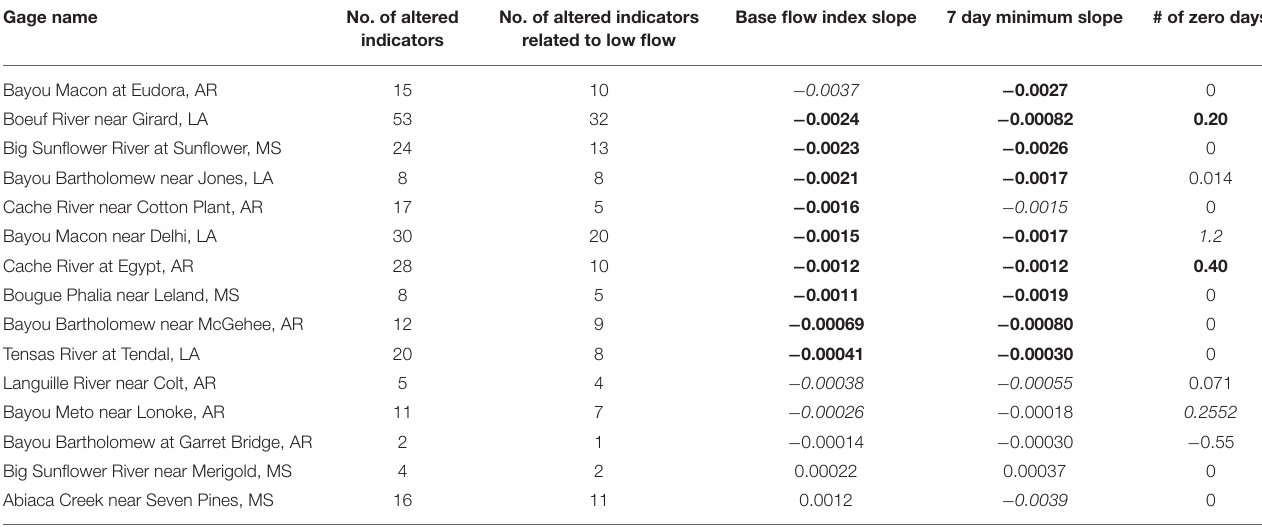
TABLE 2 | Statistics related to the Indicators of Hydrologic Alteration analysis for each gage; gages are listed from most altered to least altered with respect to the slope of the base flow